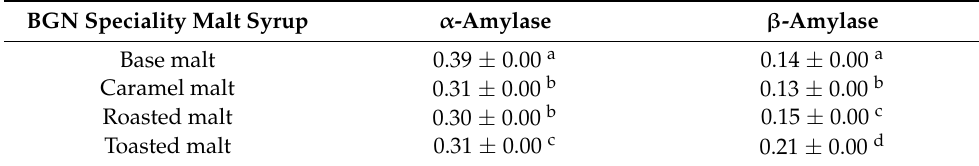
Table 5. Amylase activities of Bambara groundnut speciality malt syrups 1 .